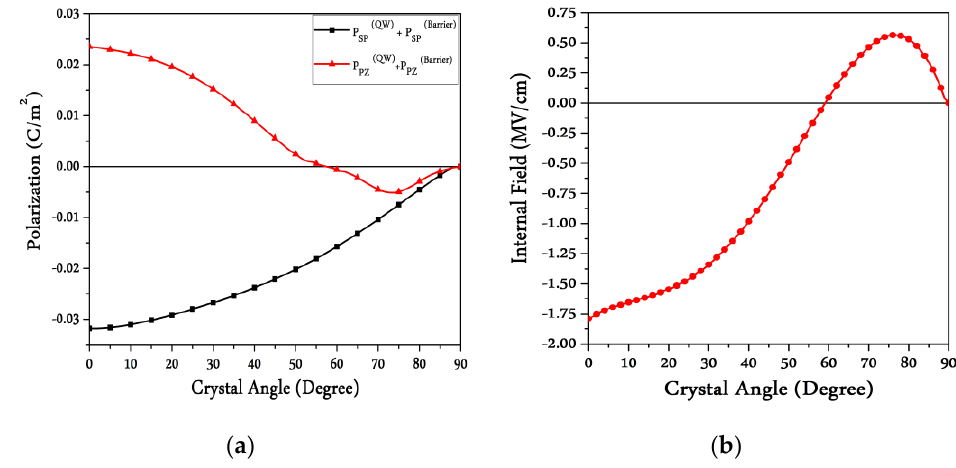
Figure 5. Strain tensor components as a function of crystal angle for 17% In composition.